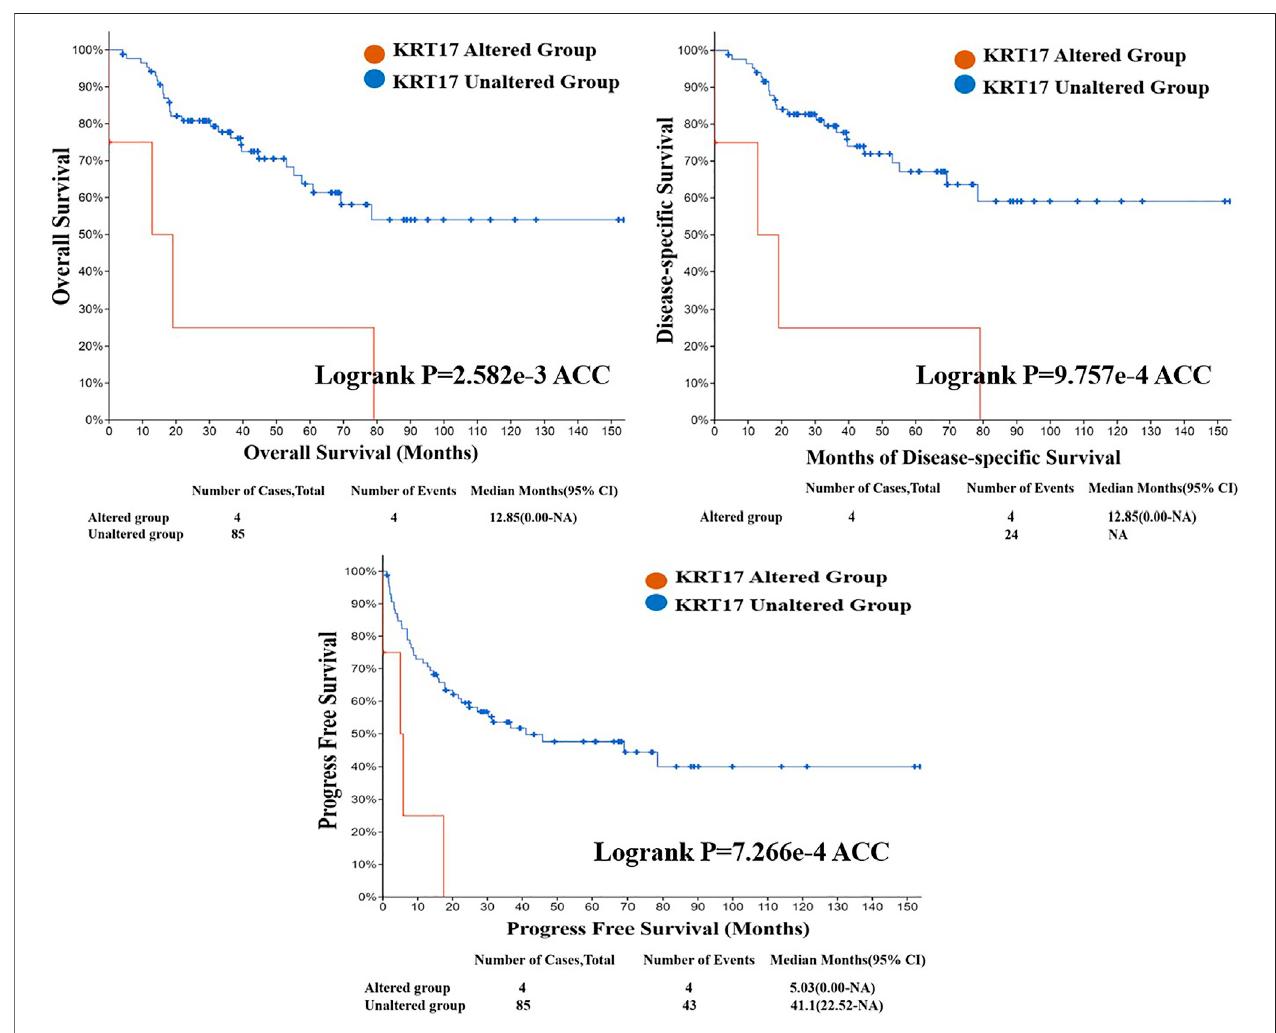
FIGURE 7 | Correlation between KRT17 mutation status and overall survival (OS), disease-speci fi c survival (DSS), and progression-free survival (PFS) ofACC. The solid red line represents the KRT17-altered group in tumor tissues, and the dash-dotted blue line represents KRT17-unaltered group in tumor tissues (TCGA dataset).